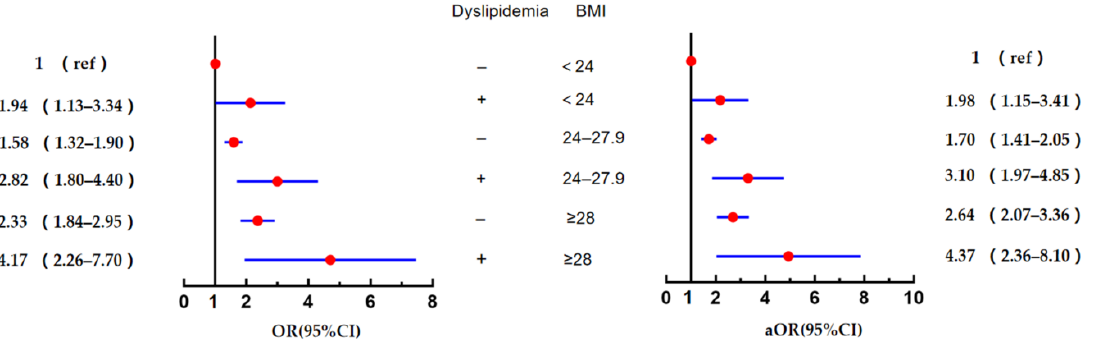
Figure 3. Combined effects of systemic obesity and dyslipidaemia on diabetes. Note: Data presented with outcome, OR and 95% CI; aOR, adjusted odd ratio (adjusted variables were age, smoking status and hypertension).